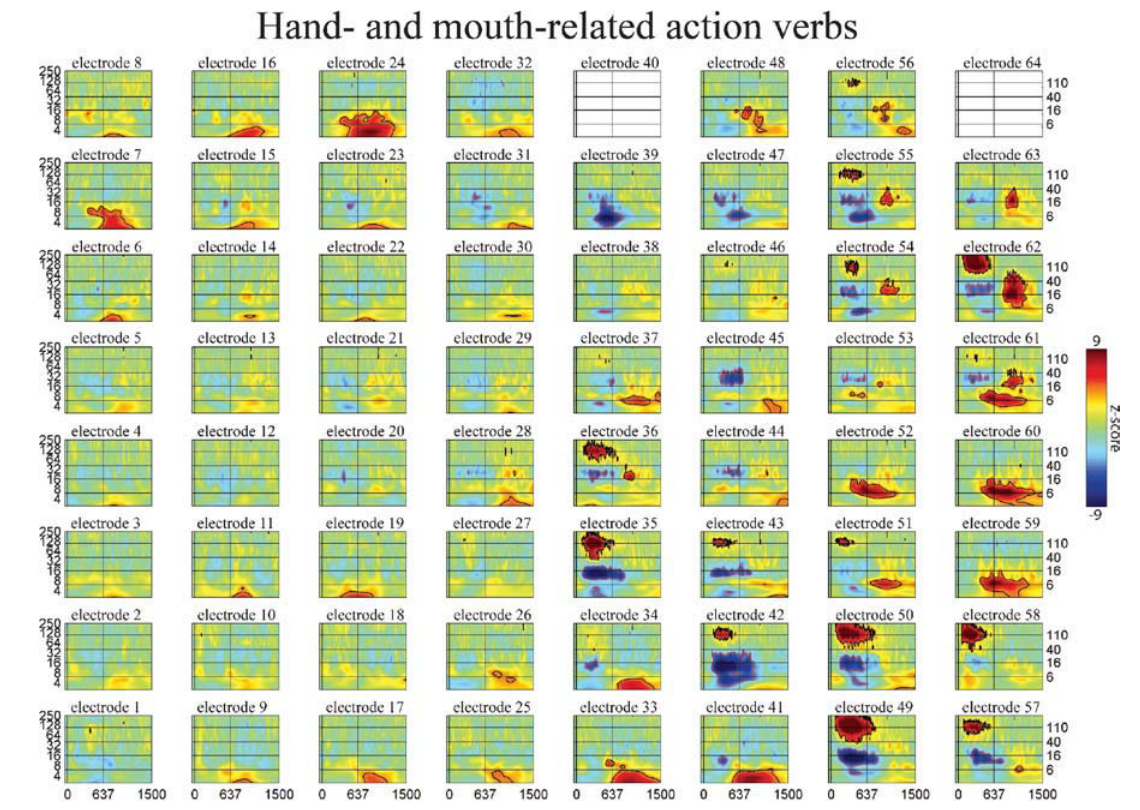
Figure 5. Event-related time–frequency plots for all electrodes in subject A in response to presentation of verbs. See Figure 4A and methods for electrode locations. Vertical lines indicate stimulus onset and offset. Horizontal lines indicated frequencies of interest (theta, beta, low gamma, and HG). Outermost black (red) contour line indicates significant power increase (decrease) (p<0.001, FDR corrected). Note that some electrodes show a similar HG response to all auditory stimuli (e.g., 58 over STG), while the HG response of others depends on linguistic category (verbs and names vs. nonwords, e.g., 49 over STS or 55 over premotor areas) or task demands (targets vs. distractors, e.g., 8 and 15 over prefrontal cortex). Other bands also exhibit stimulus specificity: e.g., theta at 59 over the inferior parietal lobule, or delta at 41 over middle temporal gyrus. (c.f. Figures 6 and 7).